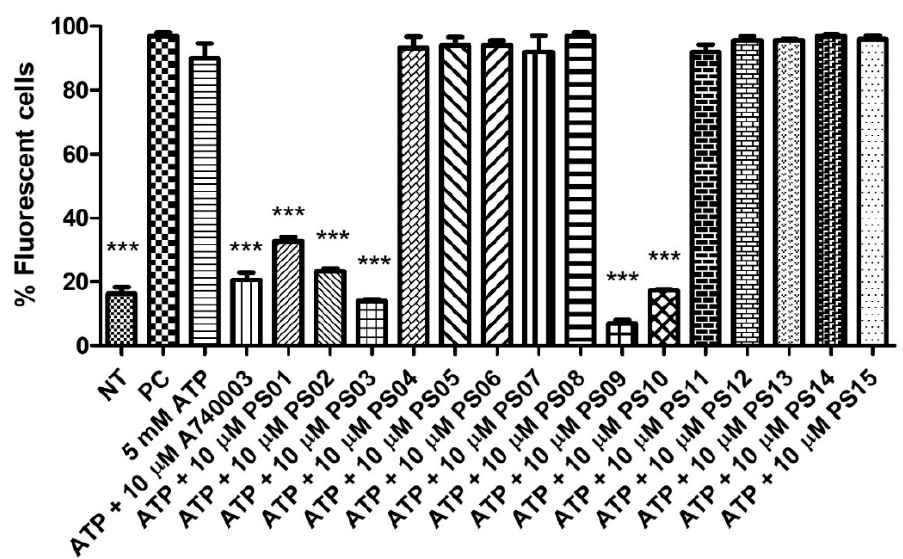
Figure 3. P2X7 receptor − induced PI uptake. Peritoneal macrophages were pretreated for 10 min with sulfonamides at 10 µ M and subsequently stimulated with 5 mM ATP for 15 min. As an inhibition control, the cells were treated with A740003 at 10 µ M for 10 min. The positive control (PC) was 0.5% Triton − X 100. Nontreated cells correspond to the negative control (NT). The bar error is representative of 3 experiments in triplicate on 3 different days. ANOVA (***) p < 0.0001.